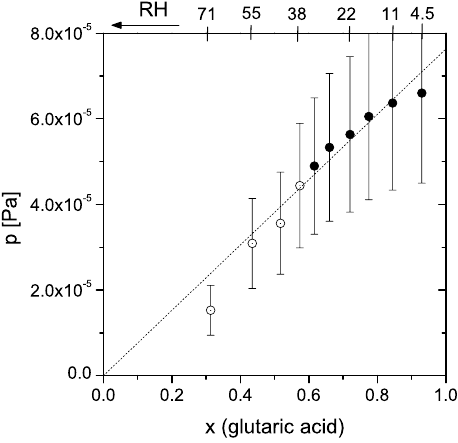
Fig. 1. Vapor pressure from evaporation rates of aqueous glutaric acid droplets at 281.3K as a function of glutaric acid mole fraction. Data at concentrations larger than x = 0 . 6 are shown as solid , see text. Dotted line shows a fit to the solid circles, to determine the vapor pressure of the pure, supercooled liquid